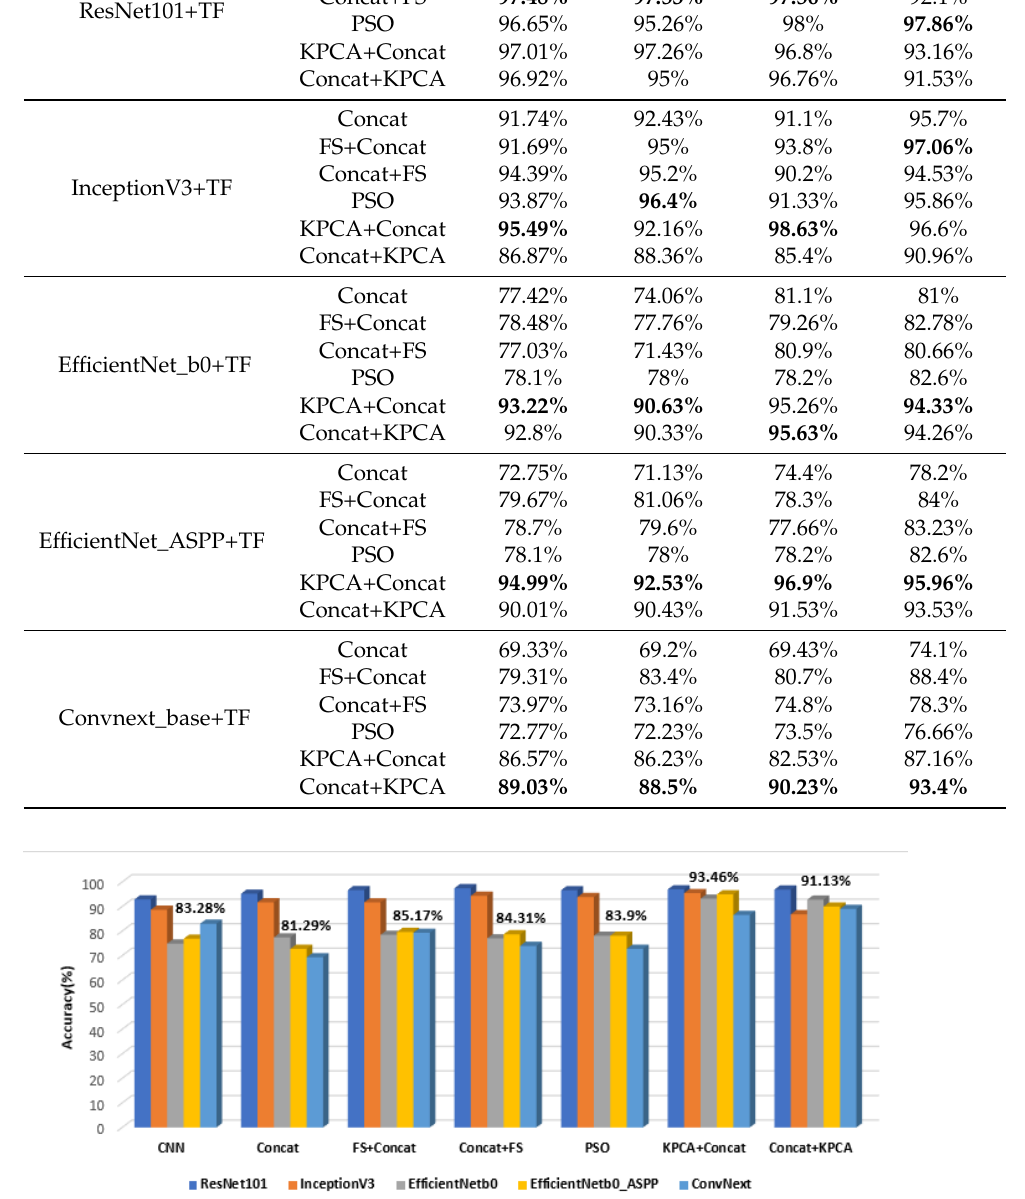
Figure 4. The comparisons between the average accuracy values obtained for each combination scheme for the considered CNN architectures in the case of the GE7